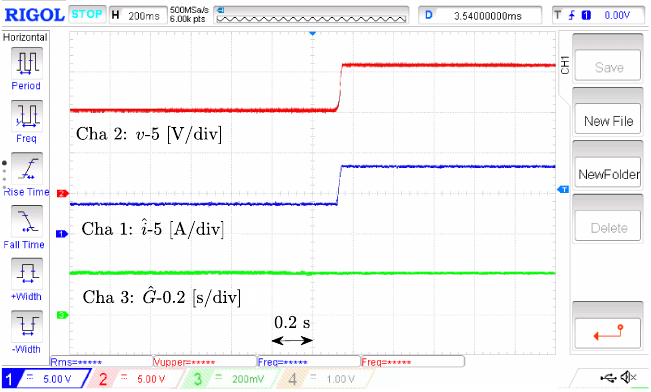
Figure 10. The response curves of boost converter under the proposed controller in the presence of a step change in the